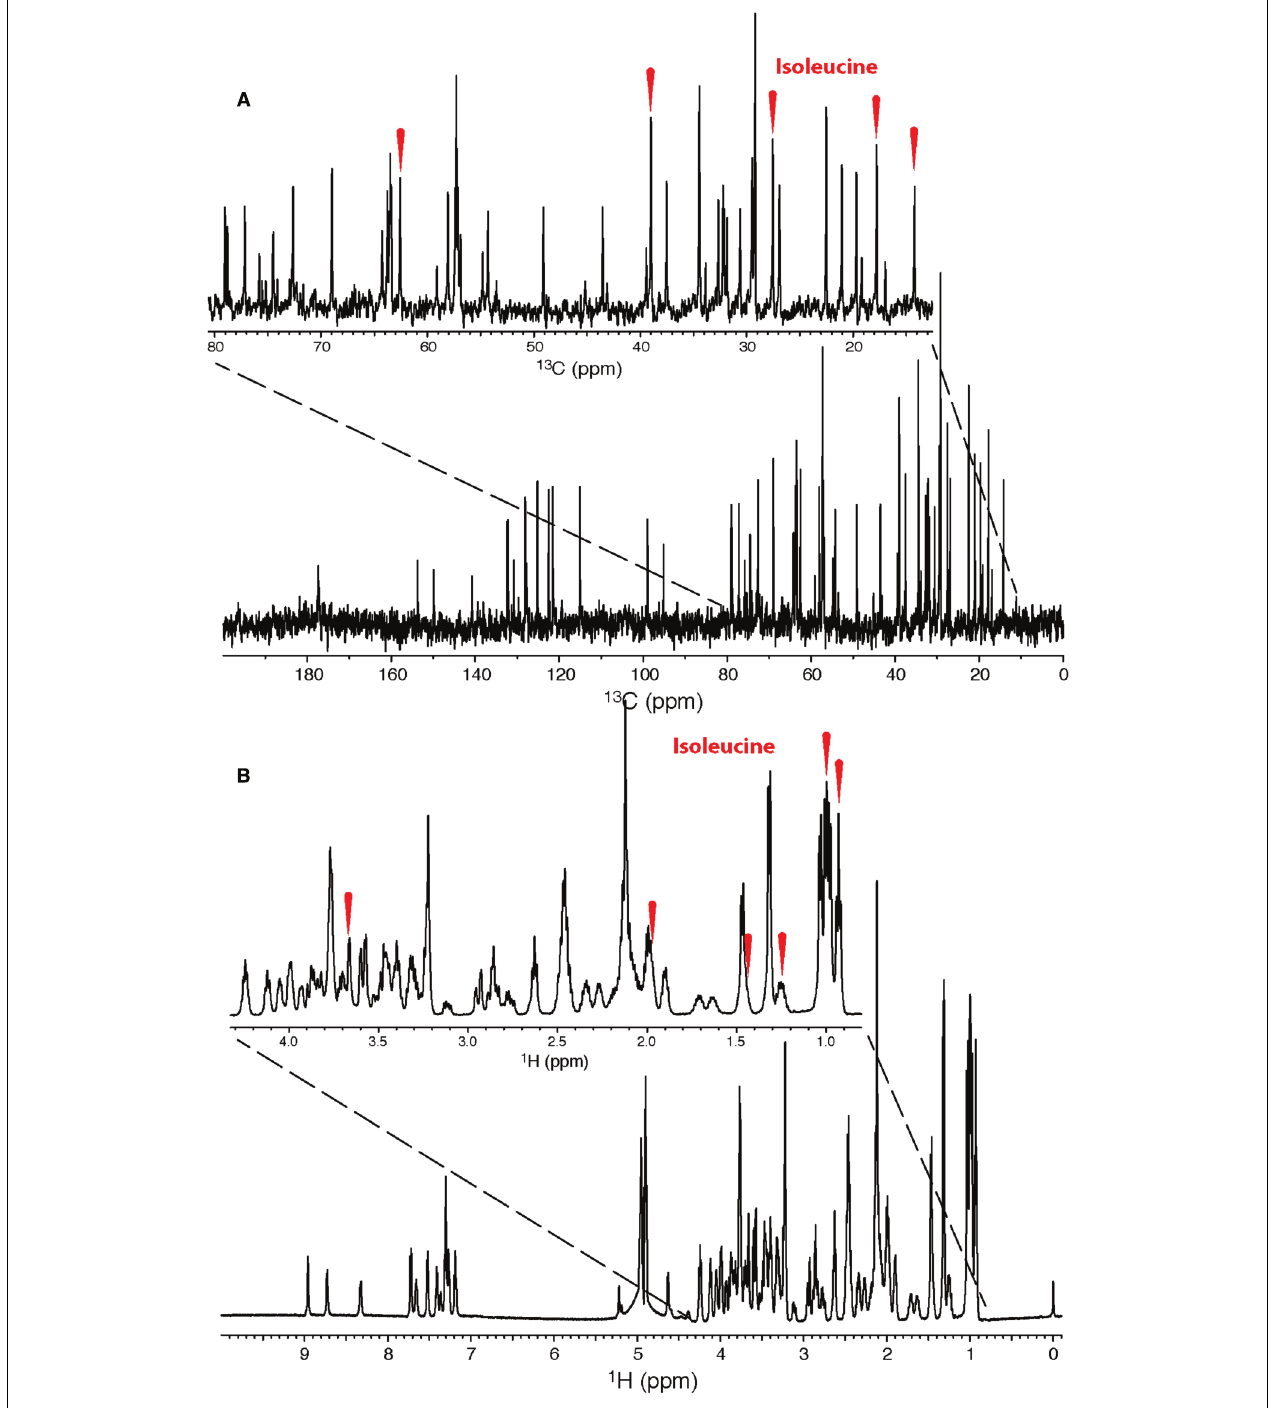
easily identified. Resonances in the corresponding 1D 1 H spectrum often overlap due to coupling and small spectral width, resulting in difficult analysis. Figure used with permission from Ramaswamy et al.